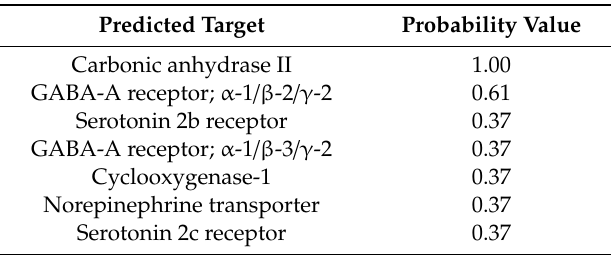
Table 1. Results of Swiss Target